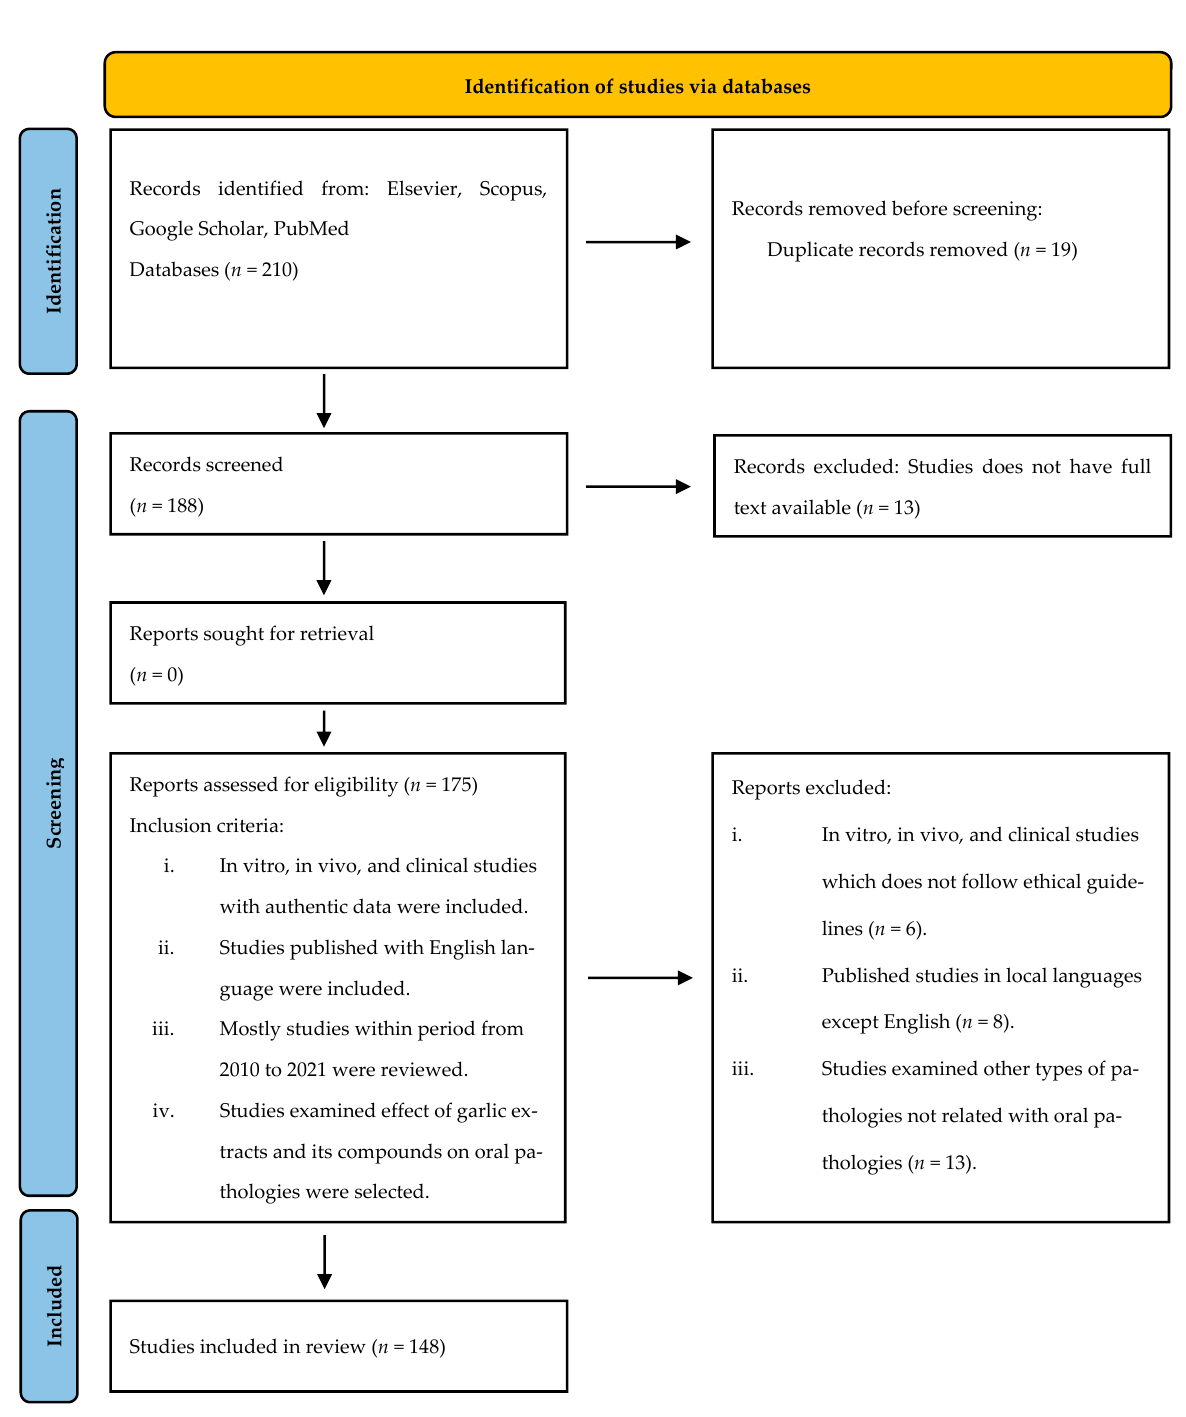
Figure 2. PRISMA flow diagram showing selection criteria.